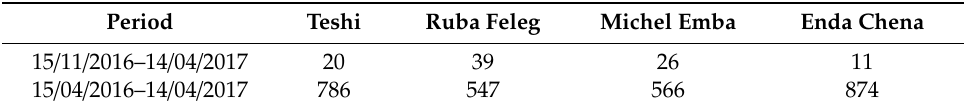
Table 7. Rainfall amounts from Climate Hazards Group InfraRed Precipitation with Station dataset (CHIRPS) dataset [50] (mm) for the period 15 / 11 / 2016–14 / 04 / 2017 (dry season before the sampling) and